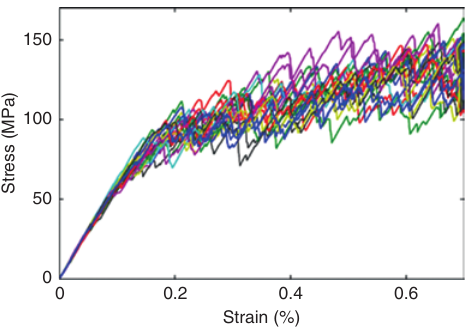
Figure 2: Stochastic nature of plastic flow as illustrated by superim- posing the stress-strain curves of 22 DDD simulations. For details see